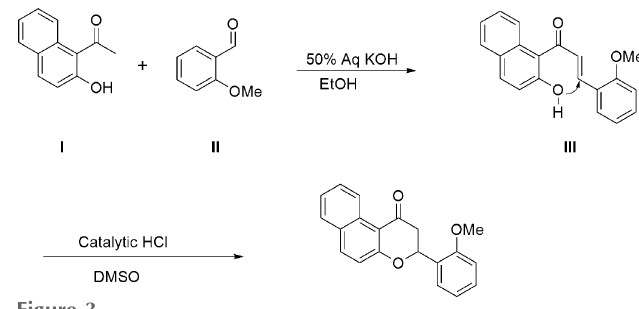
Figure 3 A synthetic scheme for the preparation of the title compound.